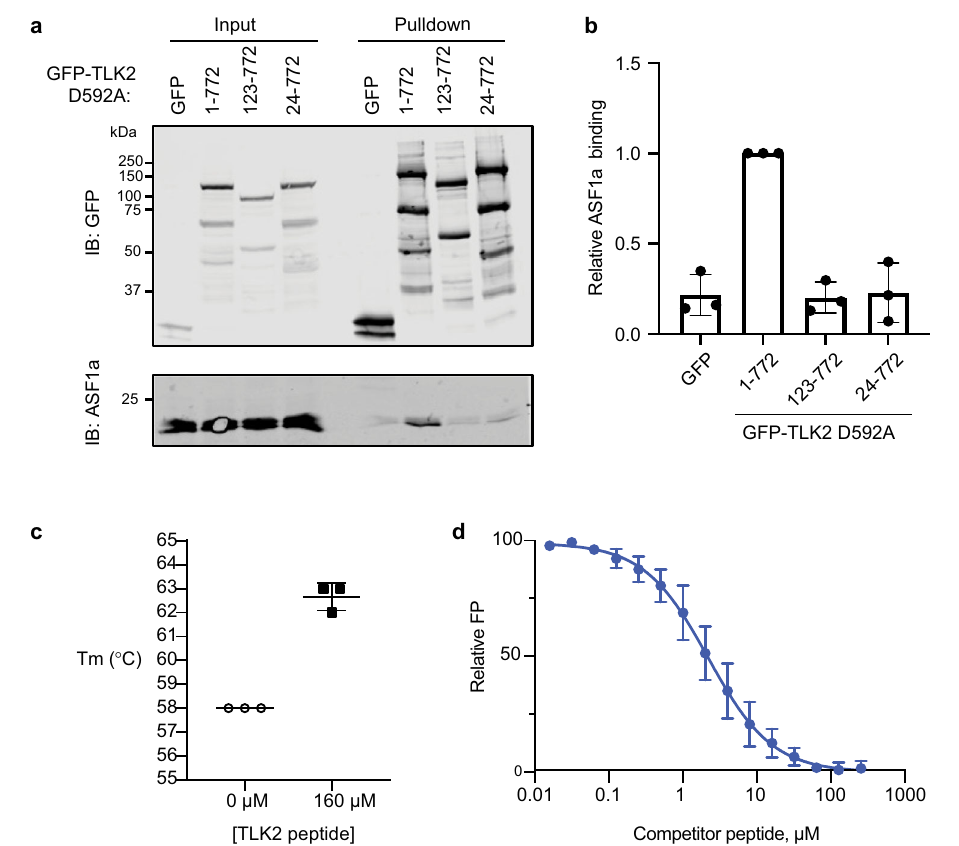
Fig. 3 A short peptide from the TLK2 N-terminus directly binds the ASF1a NT domain. a , b GFP, GFP-TLK2 (D592A) full-length (1 – 772) or N-terminal truncations (123 – 772 or 24 – 772) were expressed in HEK293T cells. Precipitated GFP proteins and co-precipitating endogenous ASF1a were fractionated by SDS-PAGE and detected by immunoblotting. A representative experiment is shown in a . Relative ASF1a binding normalized to full-length GFP-TLK2 (D592A) was quanti fi ed in three independent replicates and mean ± S.D is shown in b . c DSF was used to determine the melting temperature of puri fi ed ASF1a 1 – 155 in the presence or absence of 160 μ M TLK2 peptide spanning residues 3 – 23. Mean ± SD of three independent replicates are shown. d FP assay to assess the interaction of the TLK2 peptide with puri fi ed recombinant ASF1a-NT. Increasing concentrations of unlabeled TLK2 peptide were titrated into a mixture of a fi xed concentration of fl uorescently labeled TLK2 peptide and puri fi ed recombinant ASF1a-NT, and FP was assessed. Results are shown as mean ± SD of independent experiments ( n = 3 for competitor peptide concentrations 0 – 32 μ M, n = 2 for 64 – 256 μ M). Source data are provided as a Source Data fi le.